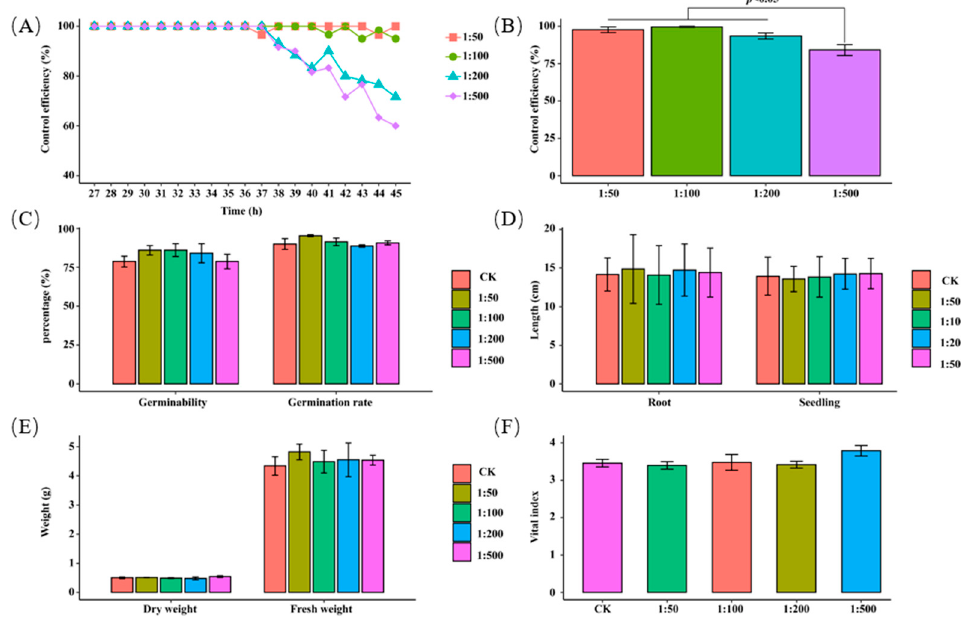
Figure 1. Effect of TFC in the laboratory. ( A ) Control effect on wheat aphid infestation ( B ) and wheat sharp eyespot. ( C , F ) Wheat germinability and germination rates, ( D ) seedling heights and root lengths, and ( E ) fresh and dry weights.